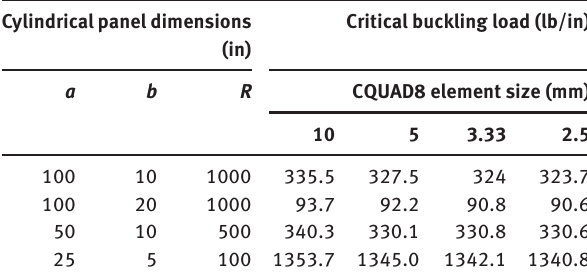
Table 2 Convergence study for isotropic cylindrical panels sub- jected to uniform in-plane load ( ν = 0.3, t = 0.096 in, E = 10 × 10 6 psi).